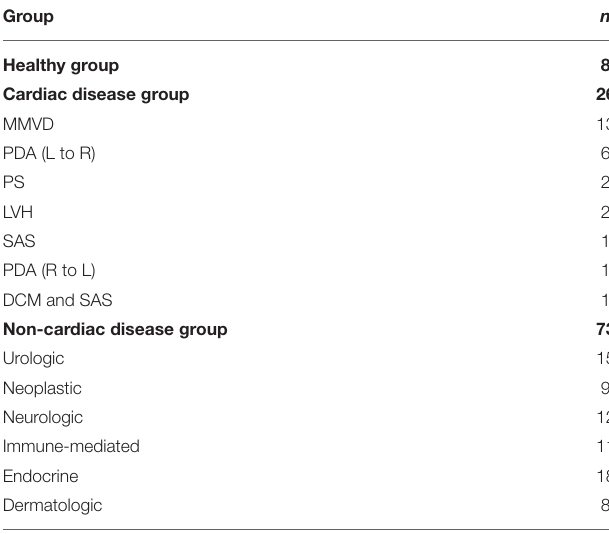
TABLE 1 | Classification of 107 dogs according to the association of heart diseases.